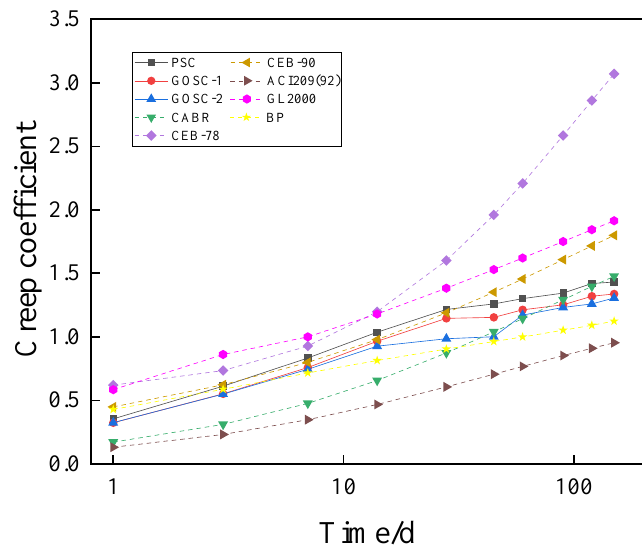
Figure 8. Comparison of the creep coefficient between calculations and experimental results of the C50 concrete. (Note: the age of the concrete uses a logarithmic scale).